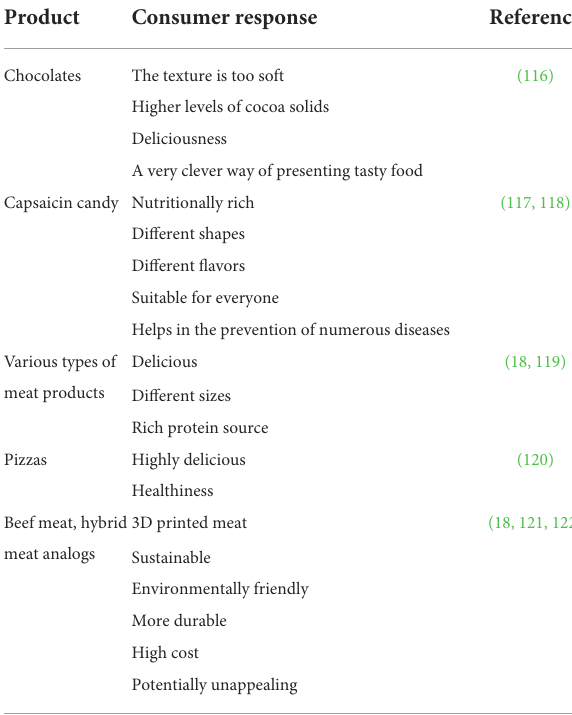
TABLE 1 Different types of 3D printed foods and consumer